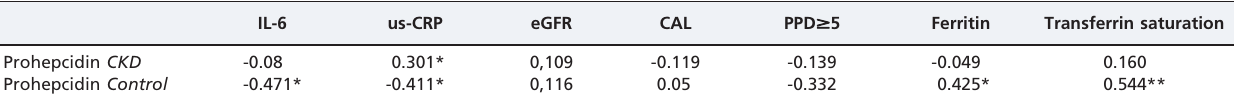
Table 4 - Pearson correlations between prohepcidin after periodontal treatment and the deltas of the independent